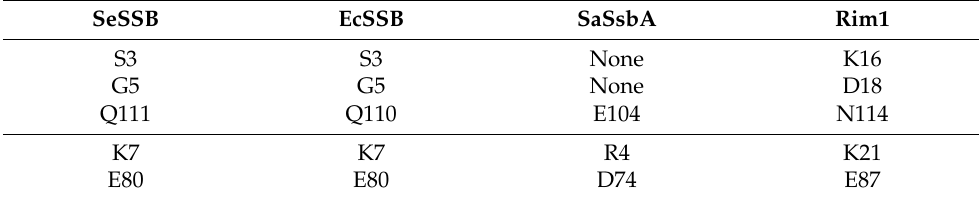
Table 2. The corresponding residues crucial for tetramerization of SSB.